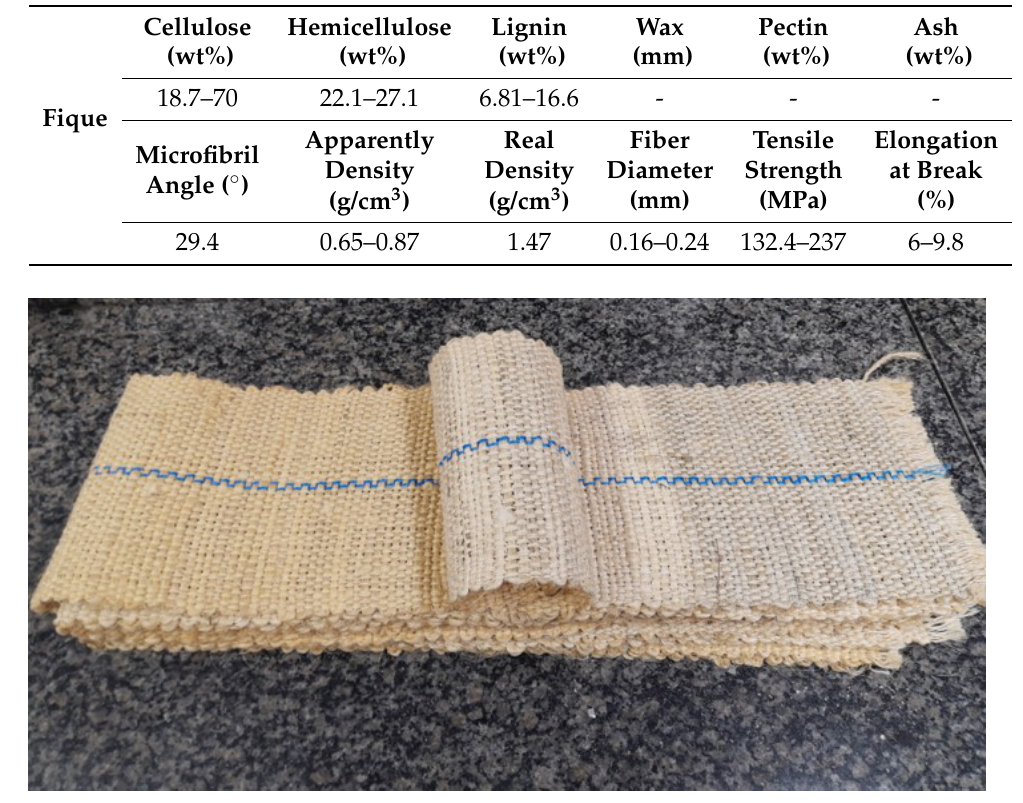
Table 1. Chemical and mechanical properties of fique fibers [22–27].